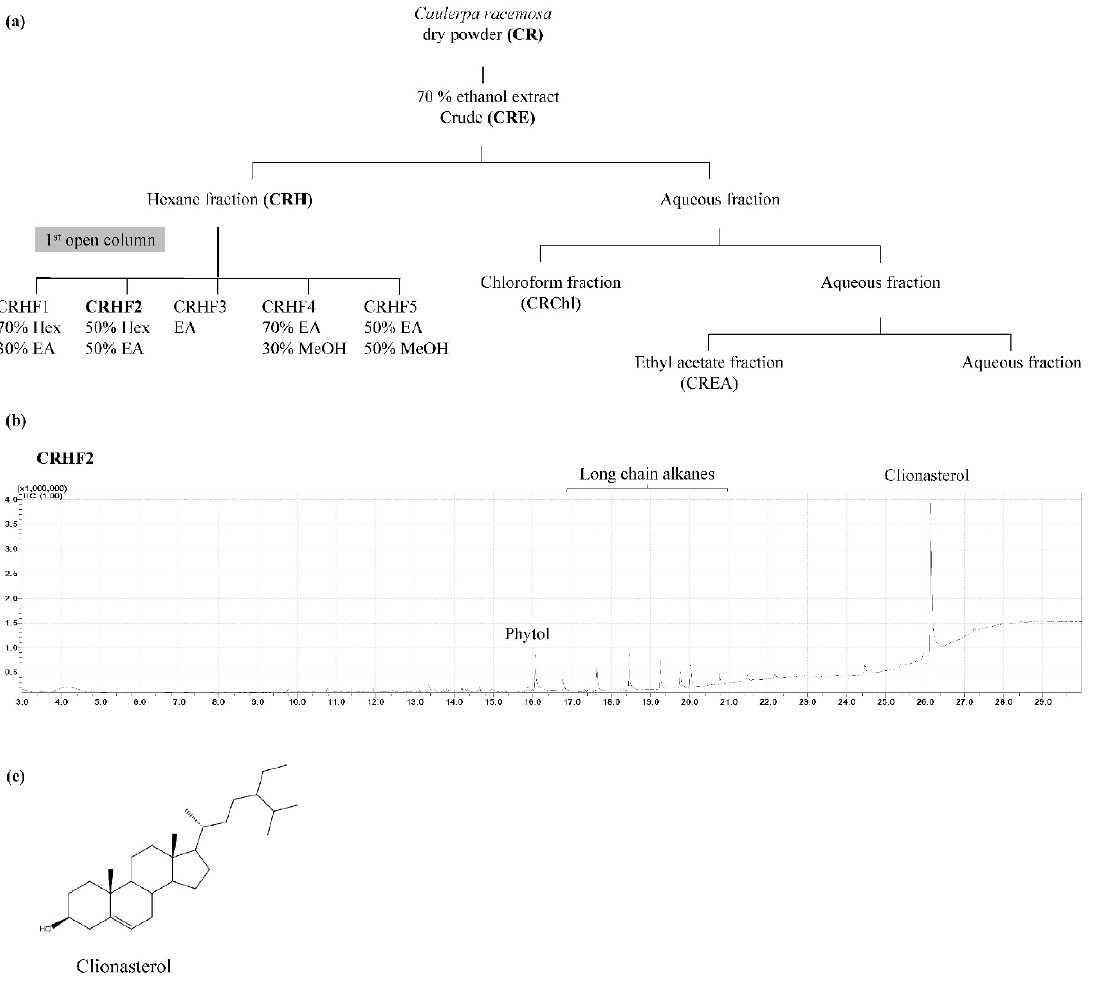
Figure 1. ( a ) Separation procedure implementing solvent/solvent extraction method leading to active fraction CRHF2, ( b ) GCMS chromatogram of CRHF2, ( c ) chemical structure of clionasterol.